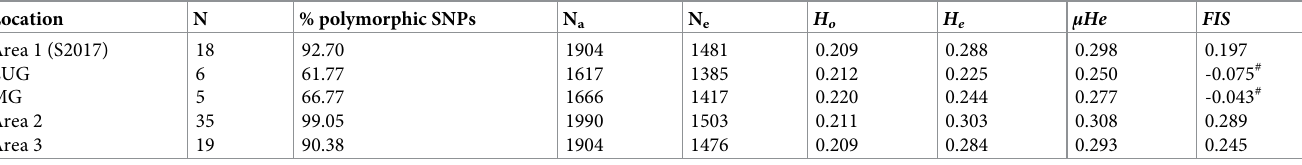
Table 1. Basic statistics of population genetic diversity for Ae . aegypti in different areas of Buenos Aires city. Location